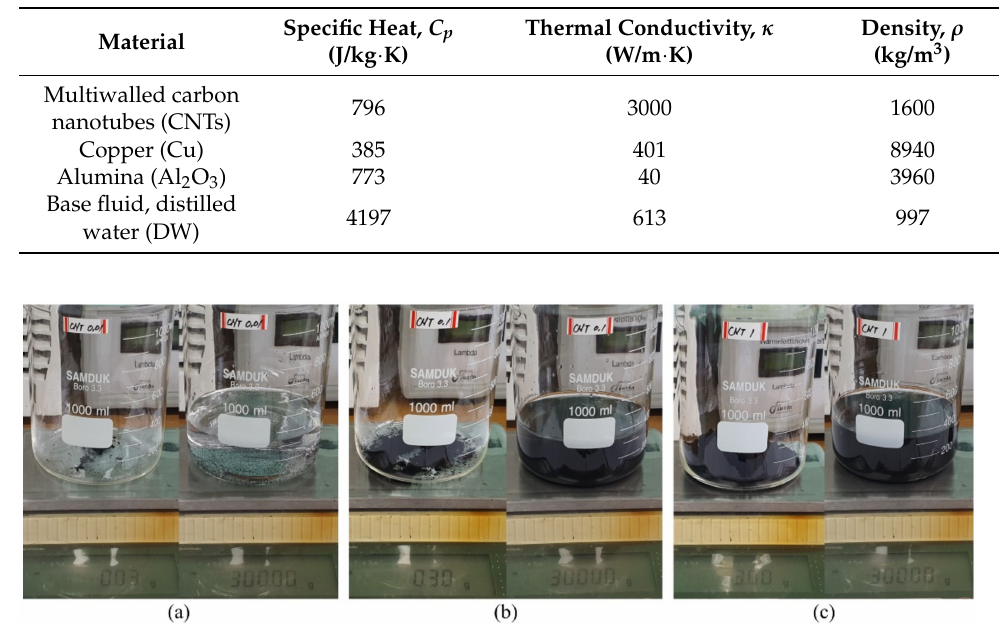
Table 1. Properties of different nanoparticles and base fluid used in the experiment [27–30].